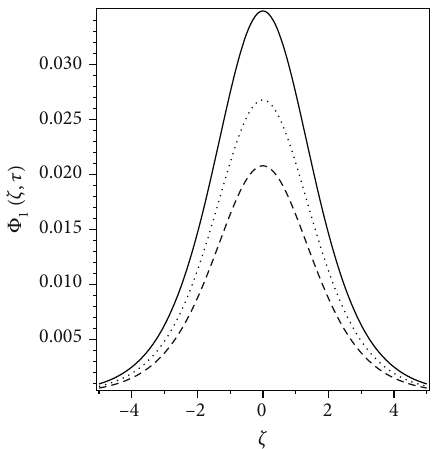
Figure 3: Single-soliton shape variations for di ff erent values of the structure parameter, k = 1 : 2 (solid line), k = 0 : 8 (dot line), and k = 0 : 4 (dashed line). σ = 0 : 1 , δ = 10 , and Γ = 170 .